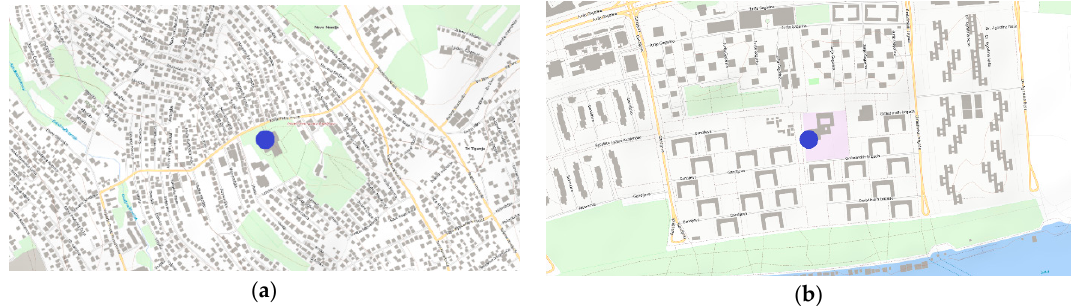
Figure 1. Larger area surrounding location of ( a ) School 1 (WGS84 20.556337261, 44.764855909) and ( b ) School 2 (WGS84 20.395445055, 44.799510267). Approximate location of indoor school space is marked as blue dot.